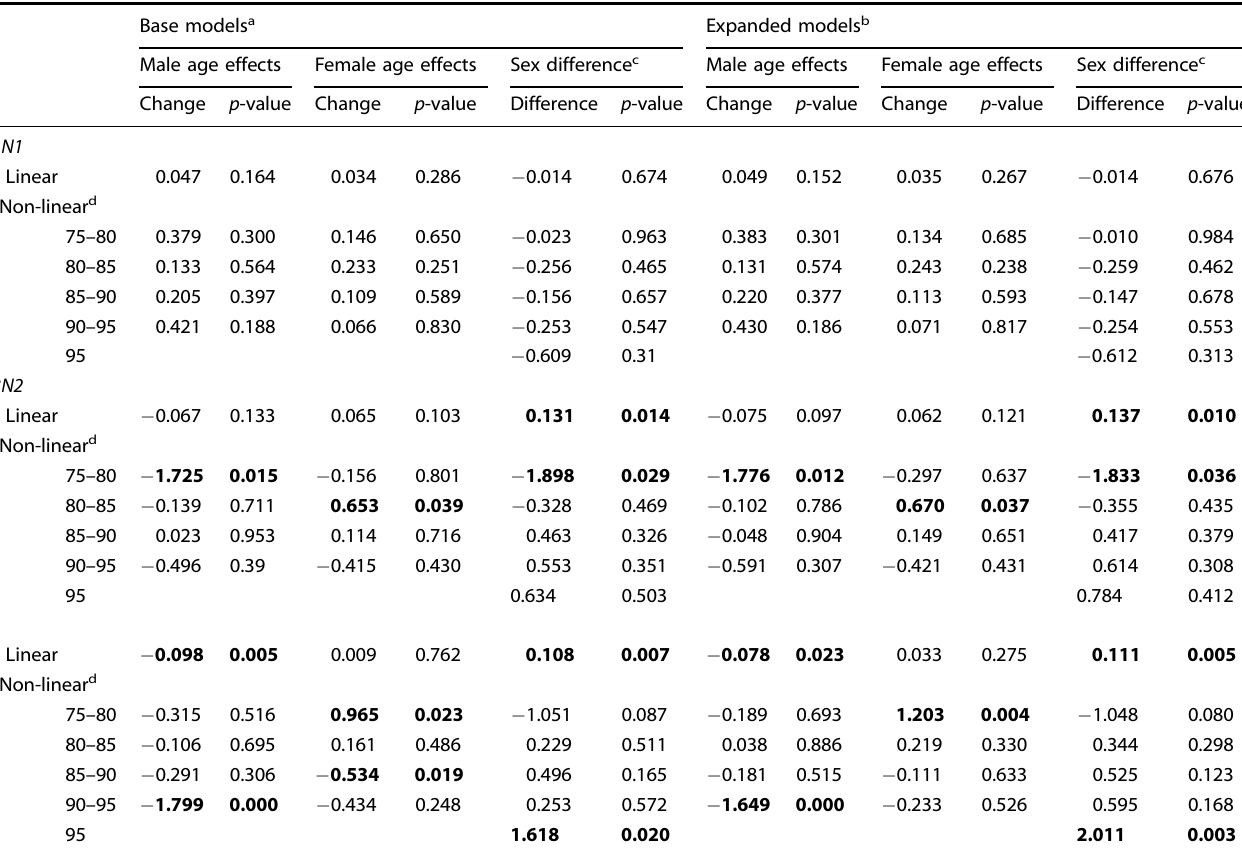
Table 3. Sex-speci fi c effects of age on pre-vaccination hemagglutination antibody inhibition (HAI)